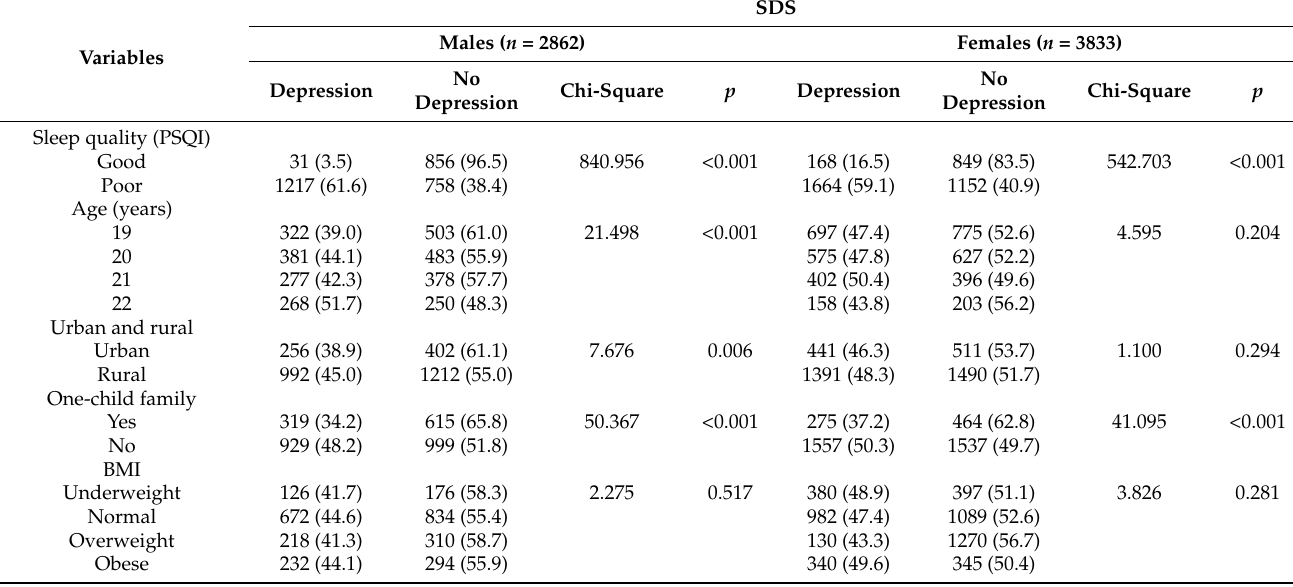
Table 1. Characteristics of depressive symptoms in college students